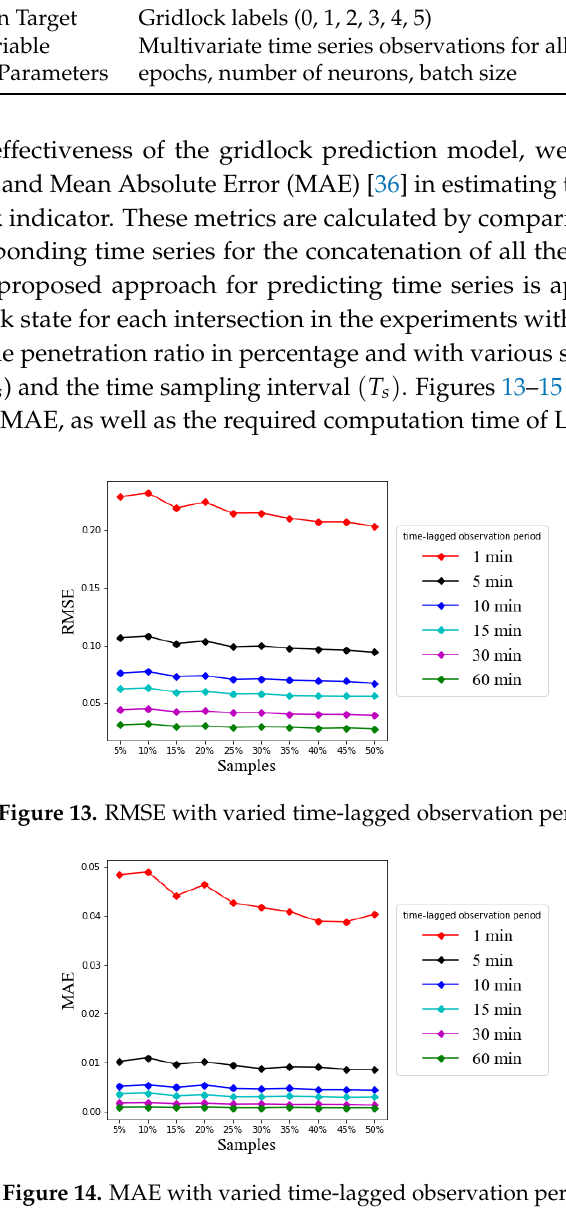
Figure 14. MAE with varied time-lagged observation